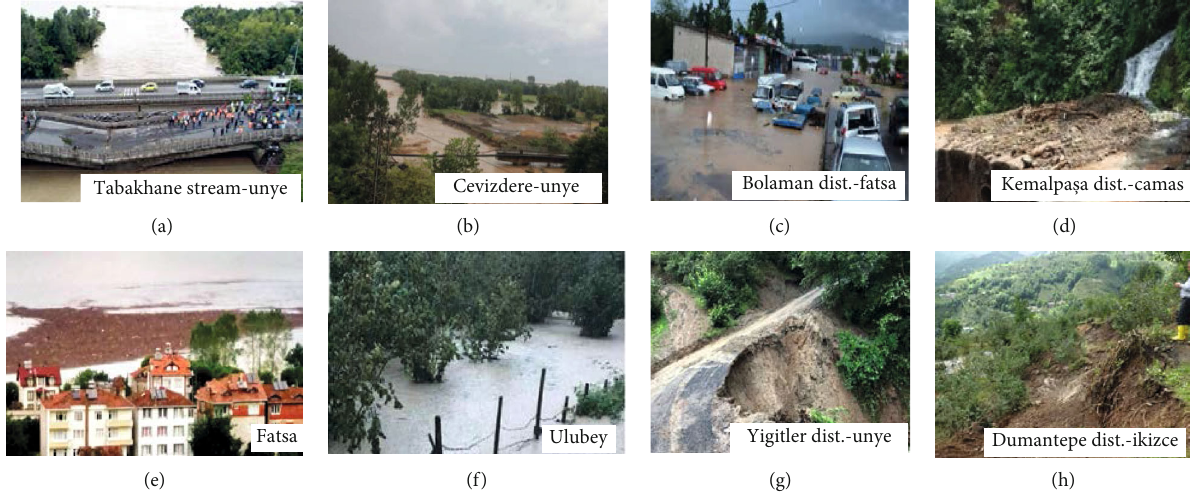
Figure 3: Some examples to the damages after Aug 8th, 2018, fl ood in Ordu (photo credits: TRT [48]).